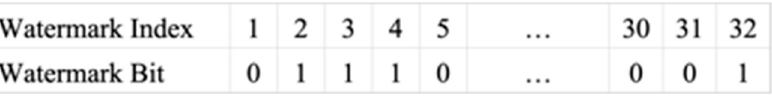
Figure 3. Demonstration of a constructed watermark.